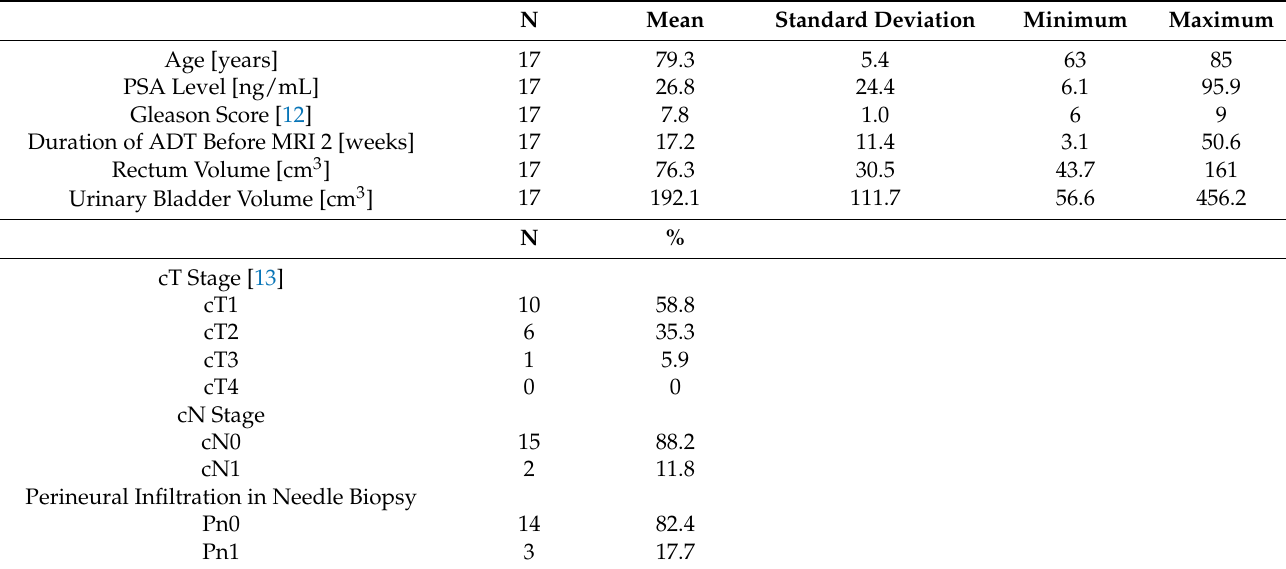
Table 1. Patient